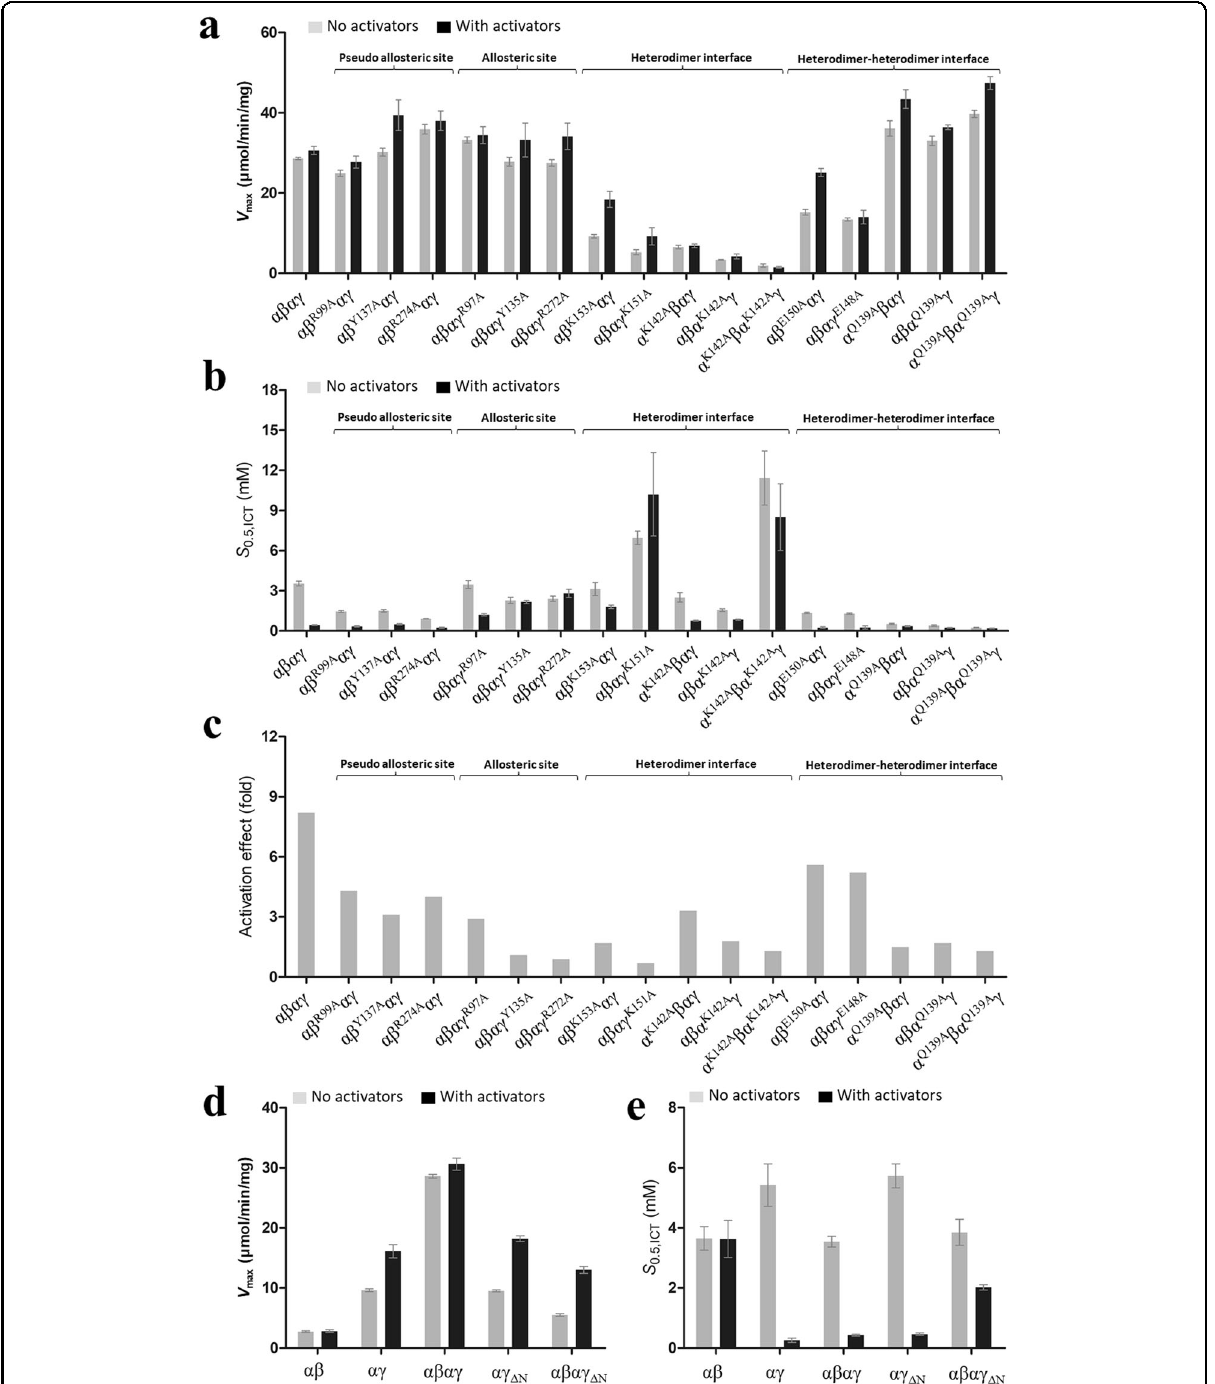
Fig. 4 Effects of the mutations on the activity and allosteric activation of HsIDH3. a Graph presentations of the V max values, b the S 0.5,ICT values, and c the activation effects of wild-type HsIDH3 and the HsIDH3 mutants containing mutations of key residues at the allosteric site, the pseudo allosteric site, the heterodimer interfaces, and the heterodimer – heterodimer interface in the absence or presence of CIT and ADP. The activation effect is de fi ned as the ratio of the S 0.5,ICT in the absence and presence of the activators. The detailed kinetic parameters are listed in Table 2. d Graph presentations of the V max values and e the S 0.5,ICT values of wild-type αβ and αγ heterodimers, wild-type α 2 βγ heterooctamer, the mutant αγ Δ N heterodimer, and the mutant α 2 βγ Δ N heterotetramer in the absence and presence of CIT and ADP. The detailed kinetic parameters are listed in Table